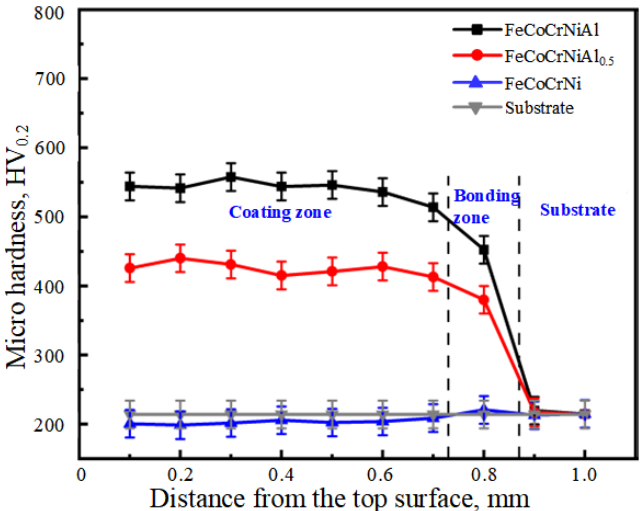
Figure 6. Micro hardness of single cladding tracks from coating top surface to substrate, the distance between the measuring points is about 100 mm.